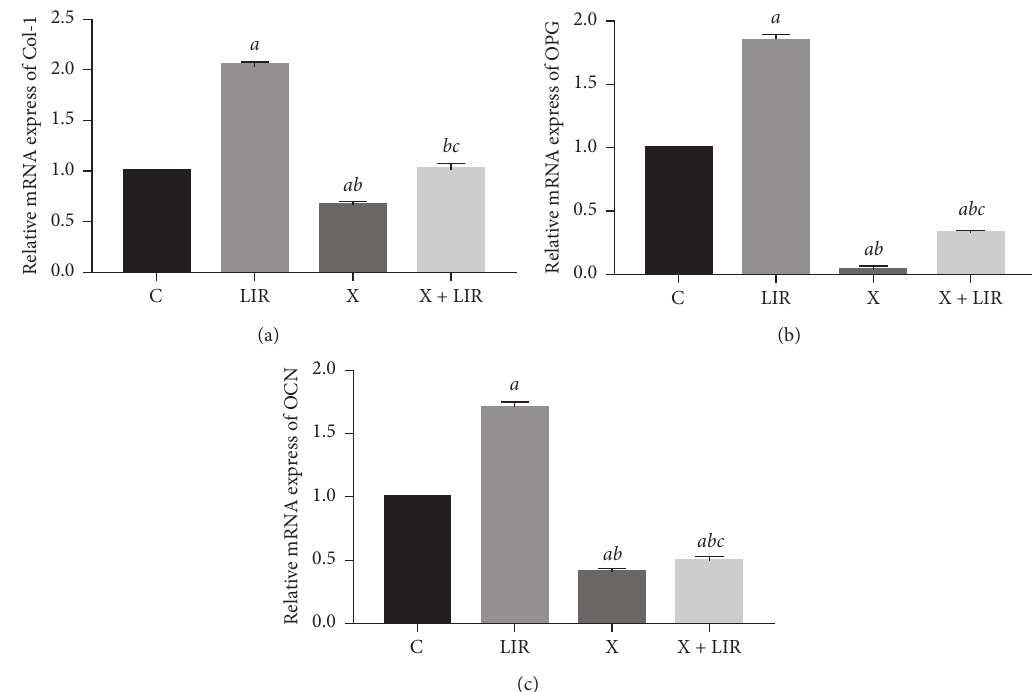
Figure 10: XMD8-92 downregulated the Col-1, OPG, and OCN gene expression. The gene expression of Col-1, OPG, and OCN was detected by RT-PCR after the MC3T3-E1 cells were pretreated with 10 μ M XMD8-92 for 1h and followed by 100nM liraglutide treatment for 48h. Quantitative analysis of the gene level of Col-1 (a), OPG (b), and OCN (c) in MC3T3-E1 cells after being pretreated with 10 μ M XMD8-92 for 1h followed by 100nM liraglutide treatment for 48h. aP < 0.01 compared with control, bP < 0.01 compared with 100nM liraglutide, and cP < 0.01 compared with XMD8-92 group. C: control group; LIR: 100nM liraglutide; X: XMD8-92; X +LIR: XMD8-92 with 100nM